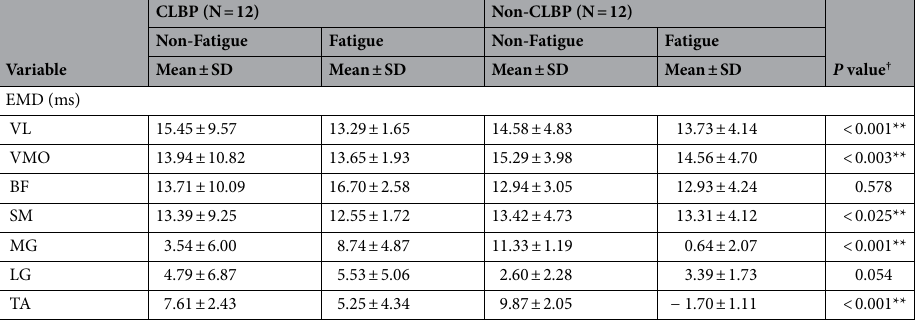
Table 3. Means and standard deviations of electromechanical delay for muscle groups/ muscles in CLBP and Non-CLBP groups. EMD electromechanical delay, VL Vastus Lateralis, VMO Vastus Medialis Oblique, BF Biceps Femoris, SM Semitendinosus, MG Med gastrocnemius, LG Lateral gastrocnemius, TA Tibialis anterior, SD Standard deviation. ** P value < 0.05 considered to be statistically significant. † Statistically significant differences between the CLBP and Non-CLBP